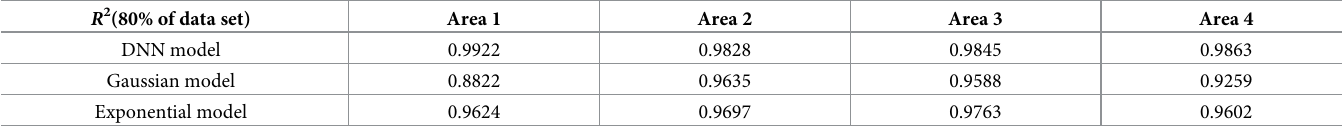
Table 1. R 2 obtained by fitting the semivariogram with different methods with the 80% of data set in the four areas. R 2 (80% of data set)